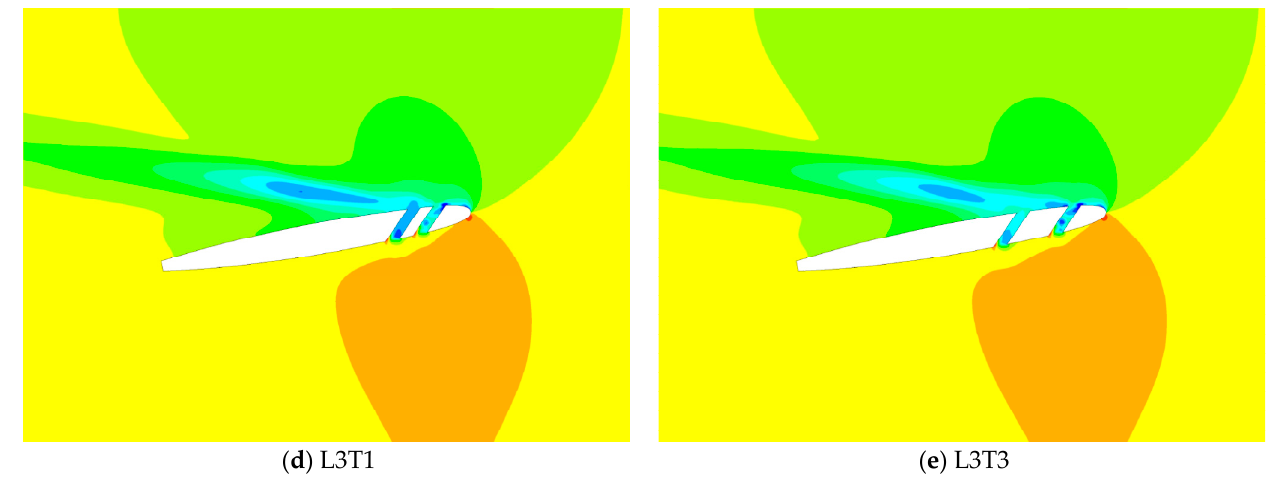
Figure 11. Pressure distribution for different schemes.